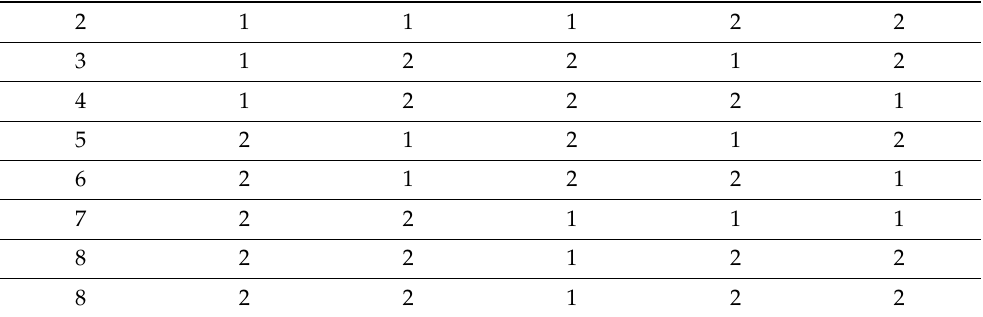
Table 6. Data on the thermal characteristics of the wake surface for each factor and each factor at different combinations of levels of surge